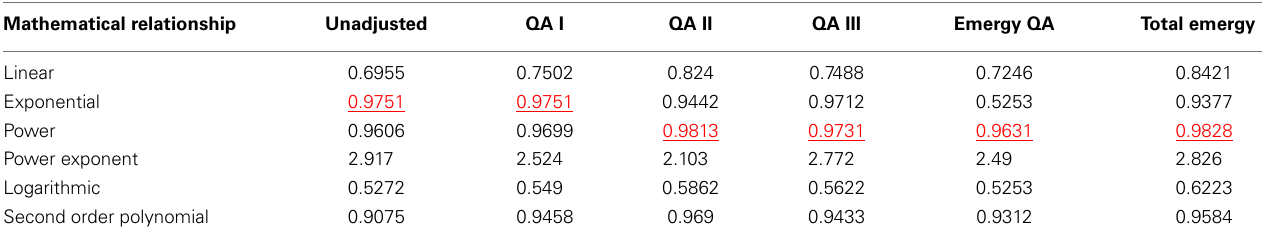
Table 2 |The R -squares of mathematical relationships between nominal GDP (Y) and measures of energy and quality adjusted (QA) energy consumed or total emergy used (X)